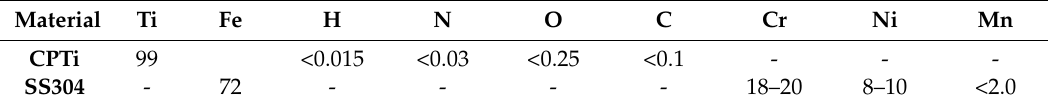
Table 1. Chemical composition of commercially pure titanium (CPTi) and stainless steel 304 (SS304) (wt.%).